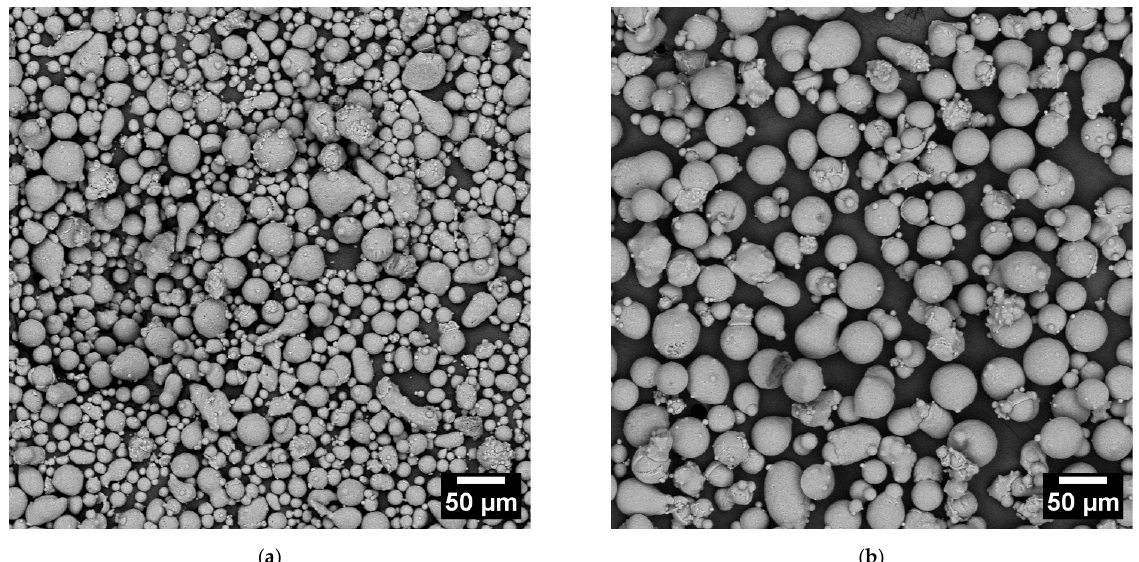
Figure 1. SEM images of the CL31 ( a ) and HM ( b ) powders. The magnification chosen was 500x. In order to deeply analyze the granulometry of the powders, image analyses were performed on the SEM micrographs, similar to those of Figure 1, and the PSDs number (Figure 2) were obtained.